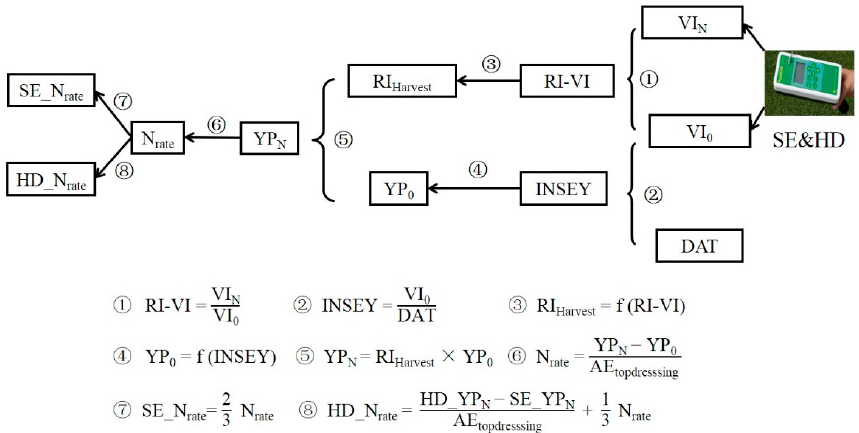
Figure 1. RapidSCAN sensor-based in-season N recommendation algorithm developed for determining topdressing N rates at stem elongation stage and heading stage of high-yielding rice in this study. VI N : vegetation index at plots with su ffi cient N fertilization plots; VI 0 : vegetation index at plots without additional N topdressing application; RI-VI: in-season N response index based on vegetation index; RI Harvest : N response index based on yield; DAT: the number of days from planting to the date of sensing; INSEY: in-season estimate of yield; YP 0 : the potential yield without additional topdressing N application; N rate : recommended topdressing N application rate at stem elongation stage; AE topdressing : agronomic e ffi ciency of topdressing N; SE_YP N or HD_YP N : the potential yield with added topdressing N application at the stem elongation stage or heading stage, respectively; SE_N rate or HD_N rate : recommended topdressing N application rate at the stem elongation stage or heading stage,